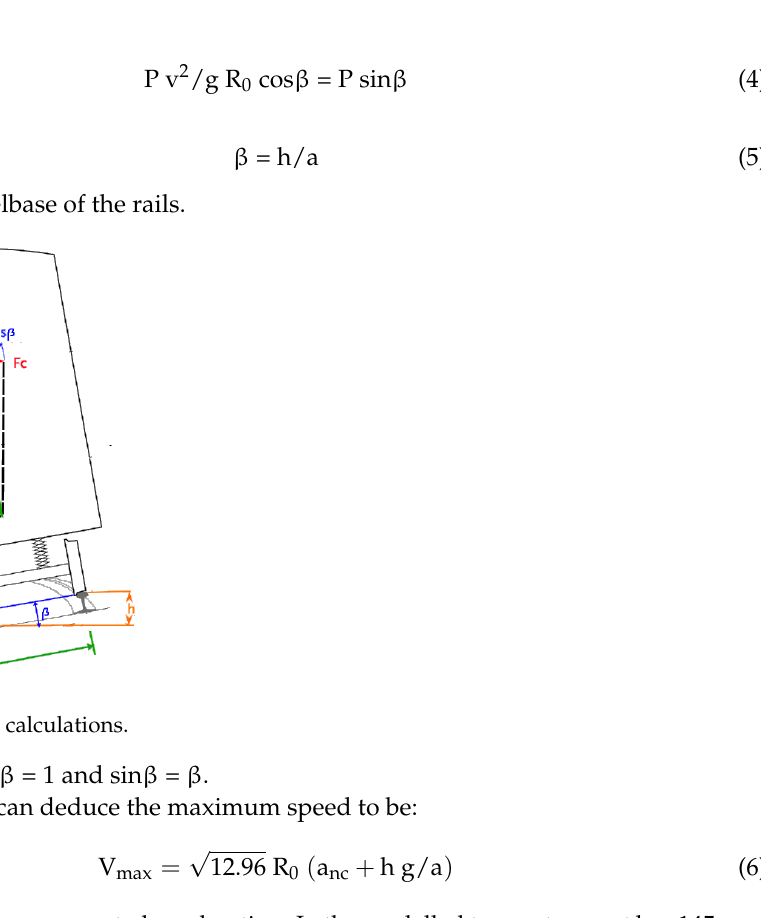
Figure 8. Wheel/rail flange clearance .